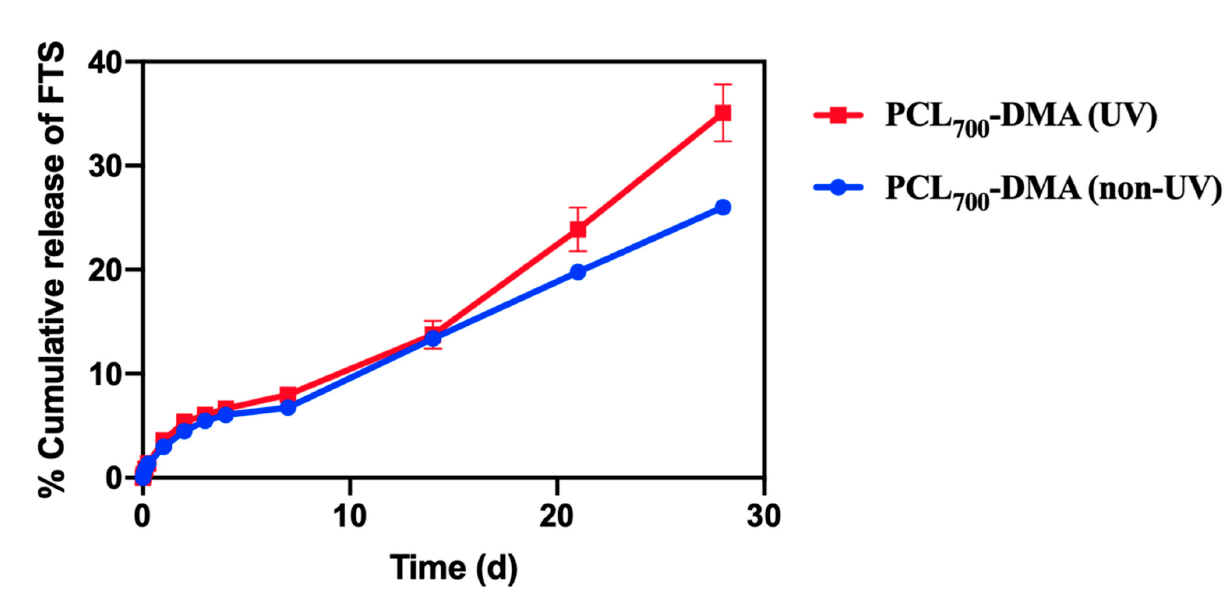
Figure 2. In vitro release kinetics of FTS from non-UV- and UV-cured rings printed with PCL 700 -DMA resin formulation. Rings were incubated in PBS at 37 ◦ C for 30 days and sample aliquots (1 mL) were collected and analyzed by HPLC analysis. All error bars represent standard deviation for n =